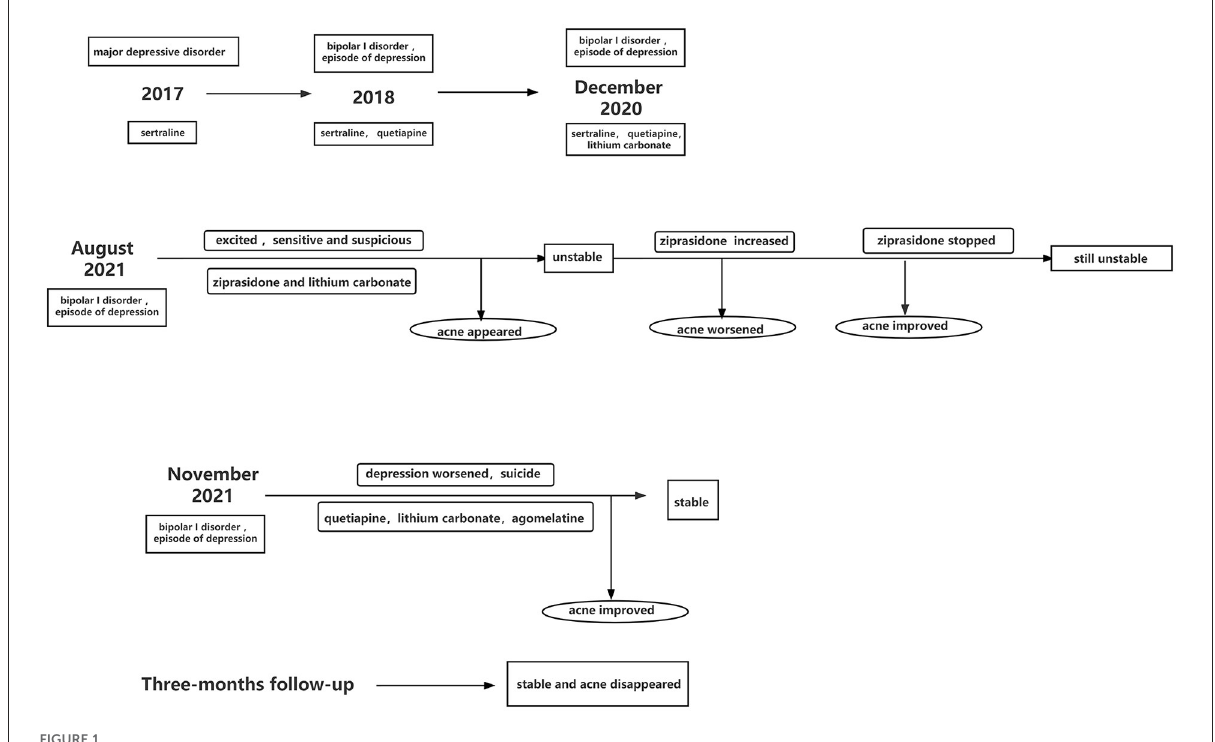
FIGURE1 Historical and current information from this episode of care.